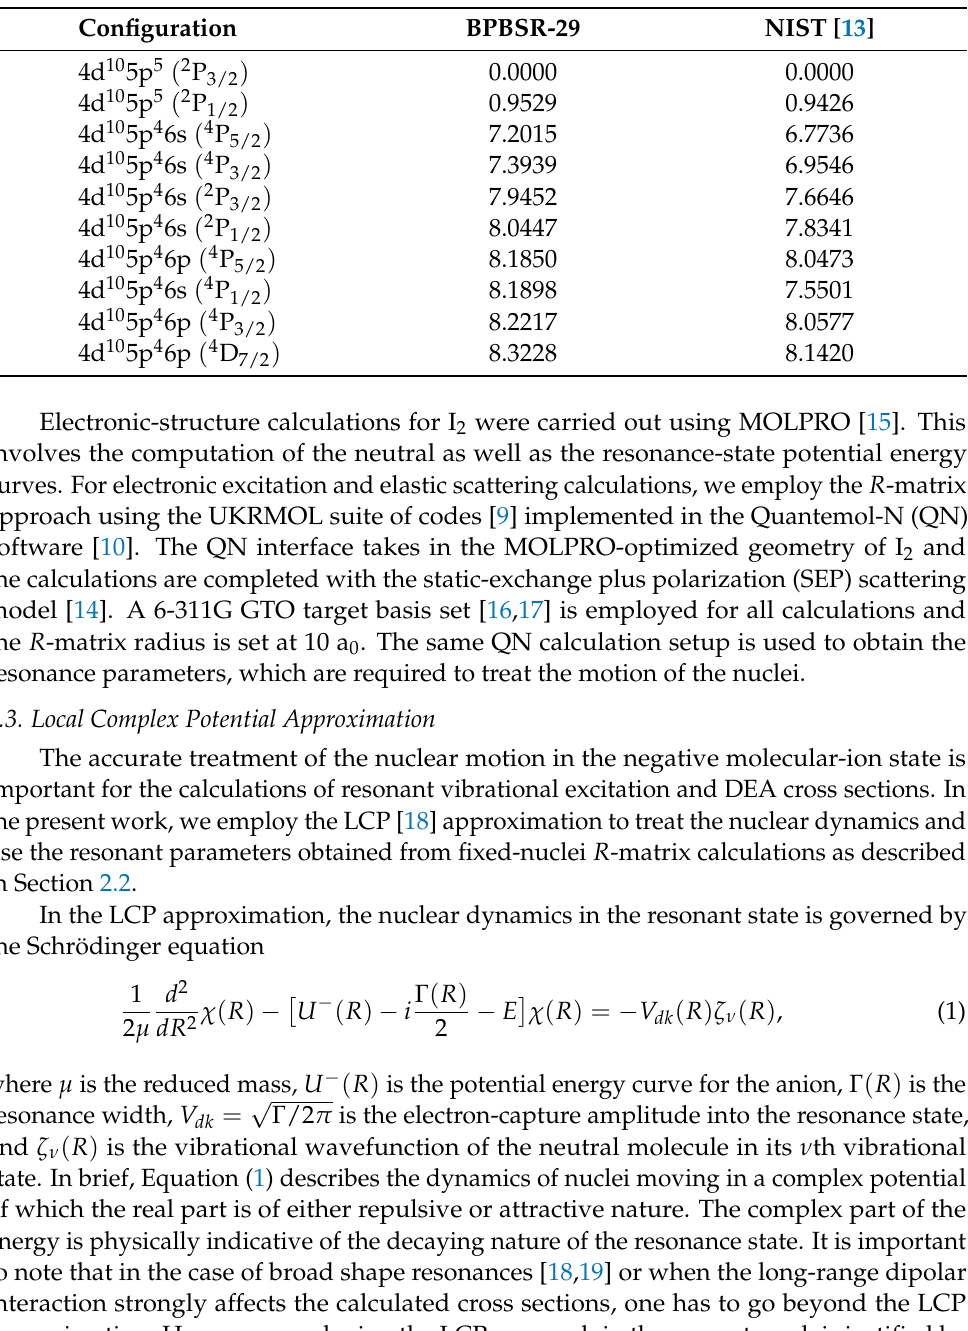
Table 2. Configurations and excitation energies (eV) for the lowest ten states of I in the BPBSR